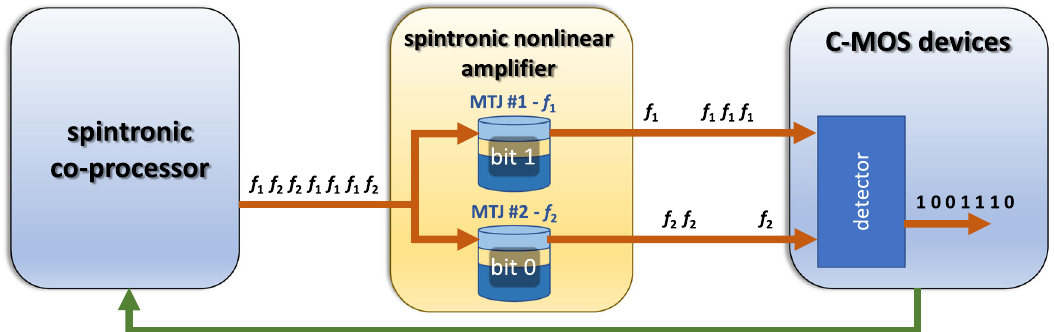
Fig. 6 | Concept of a main application of spintronic ampli fi ers in hybrid spintronic-CMOSsystems. Ideally,thespintronicpartofthecircuit(spintronicco- processor) will work at power level below the CMOS part, and then the spintronic ampli fi erswillbeusedtotransfersignalfromthespintronicsidetotheCMOSside. The communication between them can be based on the implementation of an on-